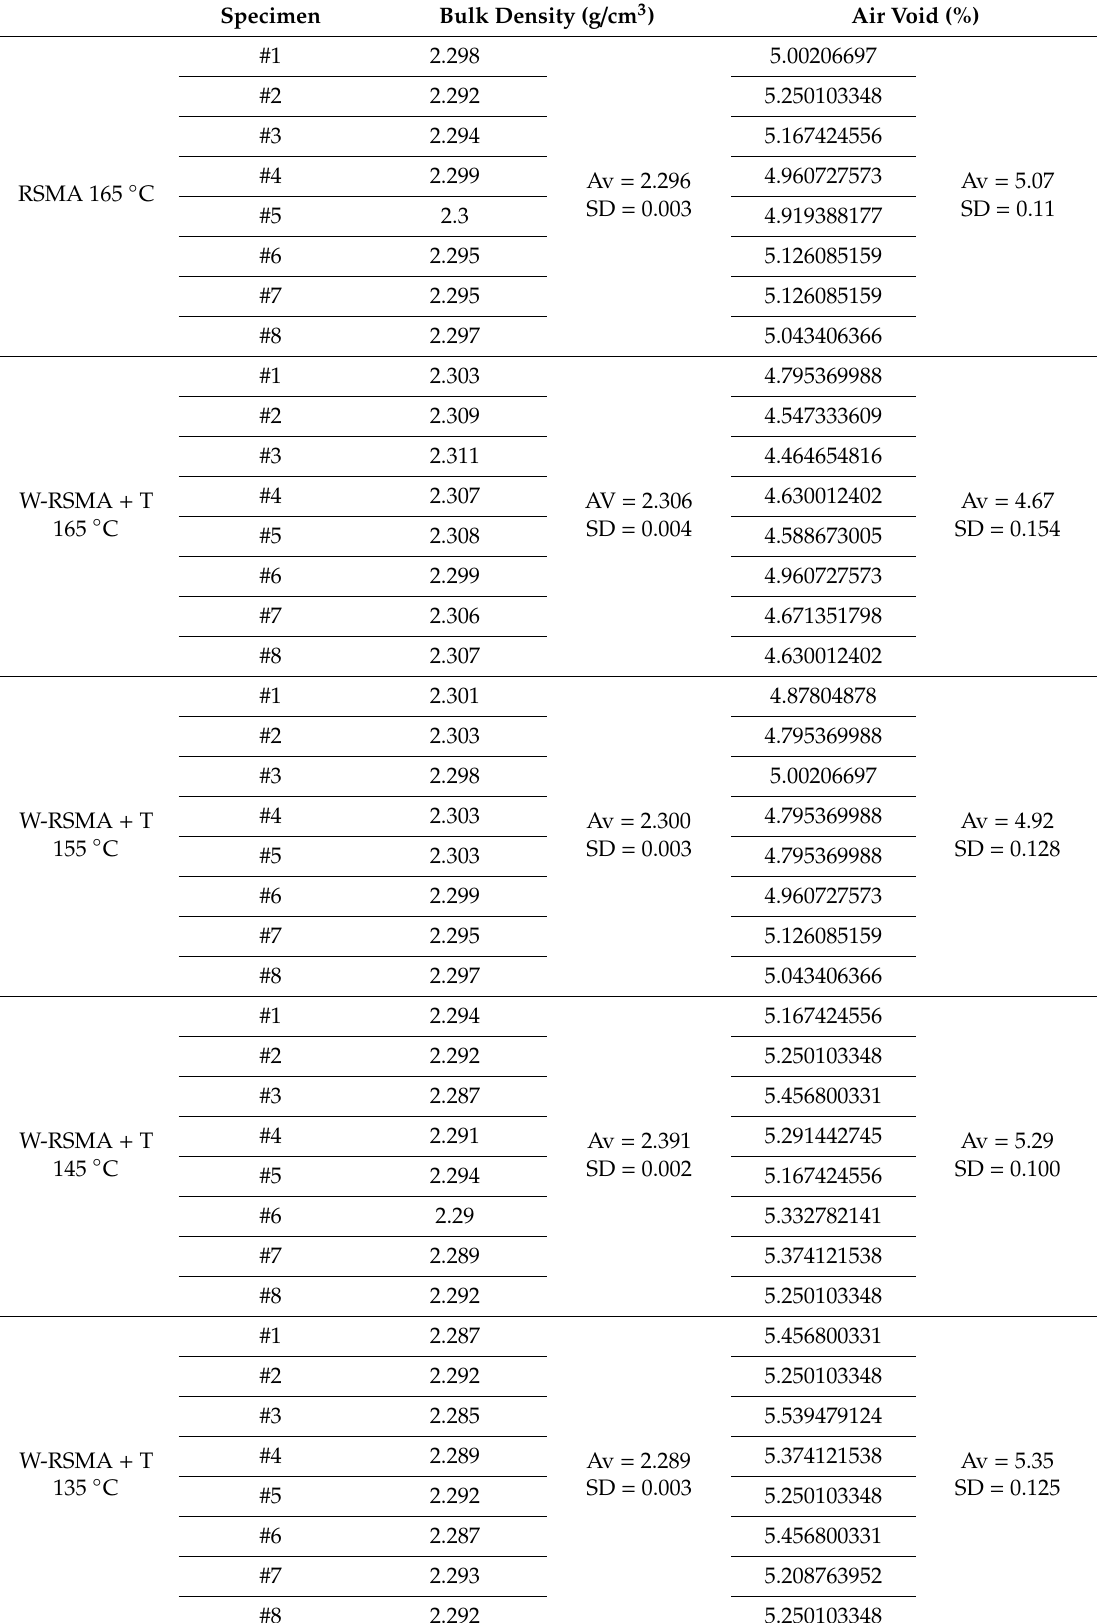
Table 7. Volumetric characteristics of the